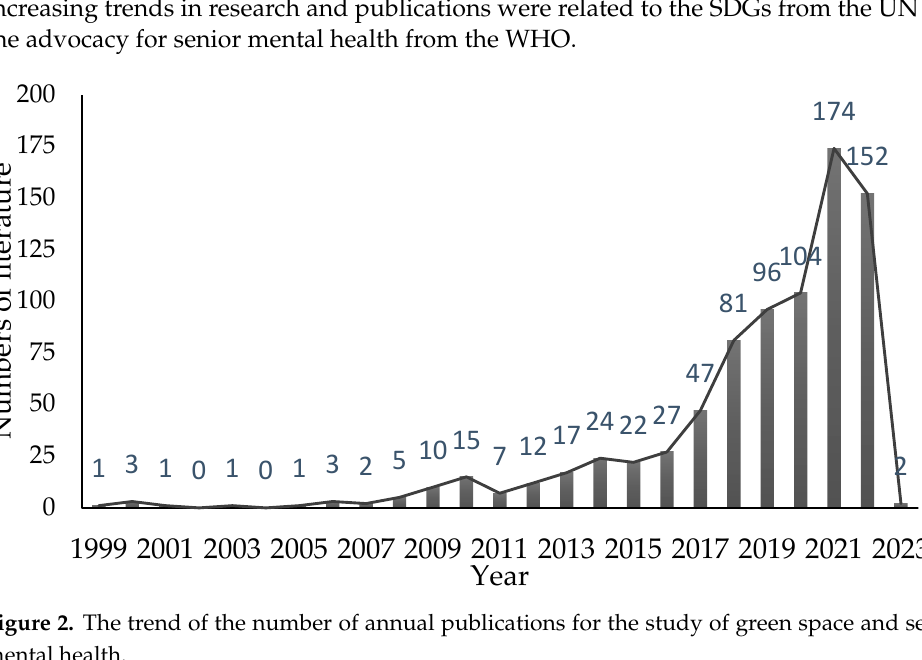
Figure 1. Flow chart of literature data collected for the study of urban green space and senior mental